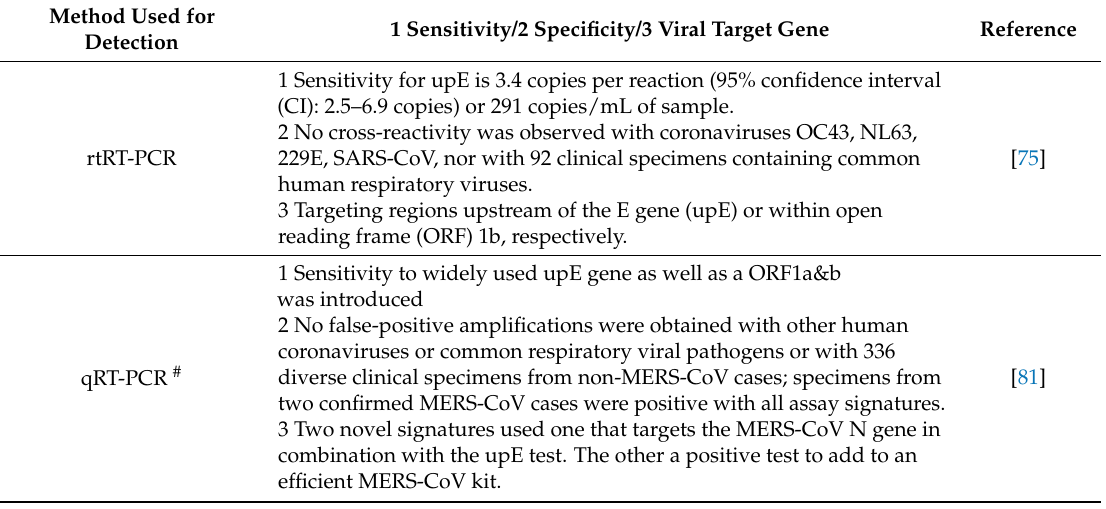
Table 1. Detection methods of